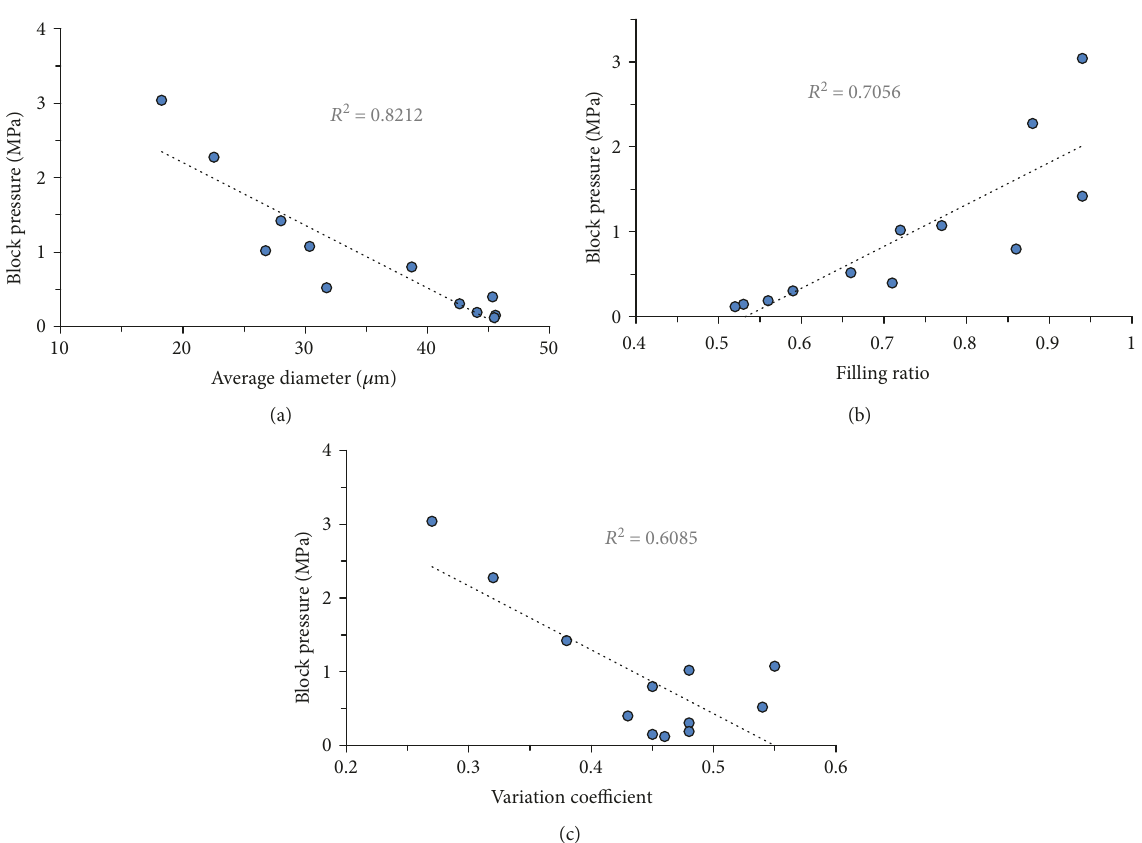
Figure 9: The relationships between foam texture and block pressure. (a) is the relationship between average diameter and block pressure. (b) is the relationship between the fi lling ratio and block pressure. (c) is the relationship between the variation coe ffi cient and block